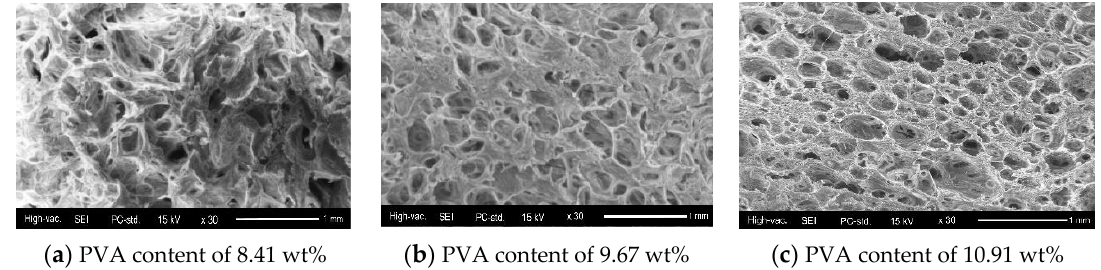
Figure 2. Morphologies of internal sections of the samples at 30× magnification. ( a ) PVA content of 8.41 wt%; ( b ) PVA